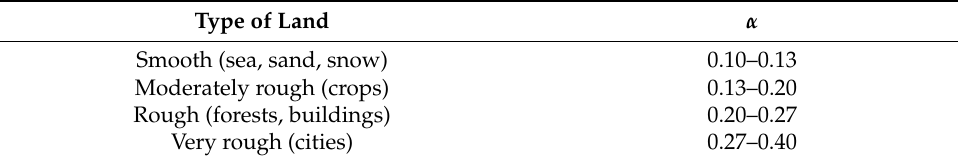
Table 8. Values of α